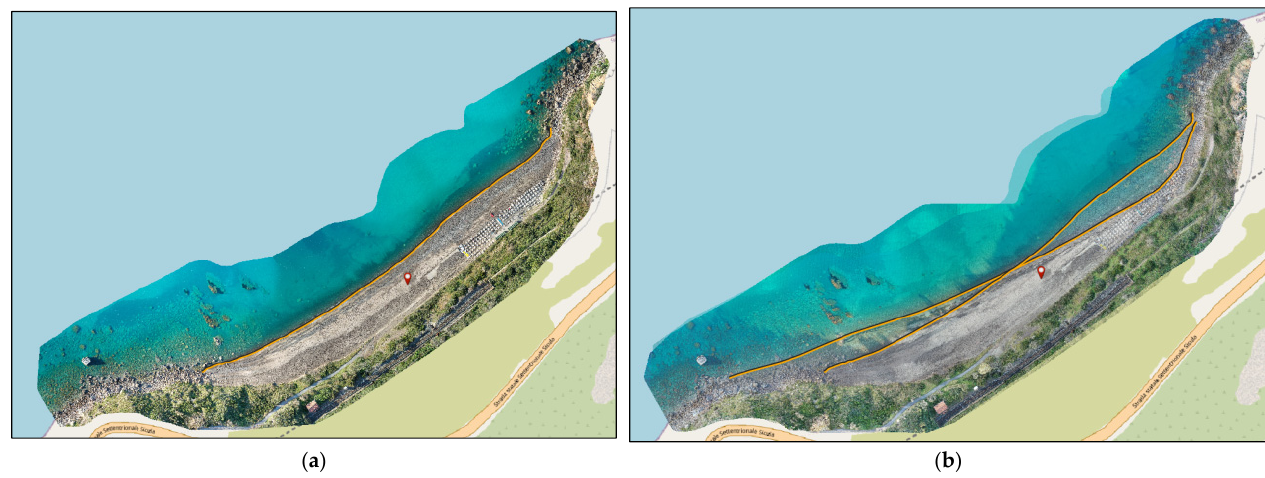
Figure 7. The figure shows a comparison of the pocket beach of Rais Gerbi (Palermo) in two different time intervals through the management of opacity: ( a ) Spring-Summer Season; ( b ) overlap of Autumn-Winter season on Spring-Summer season. The respective shorelines are highlighted in orange.